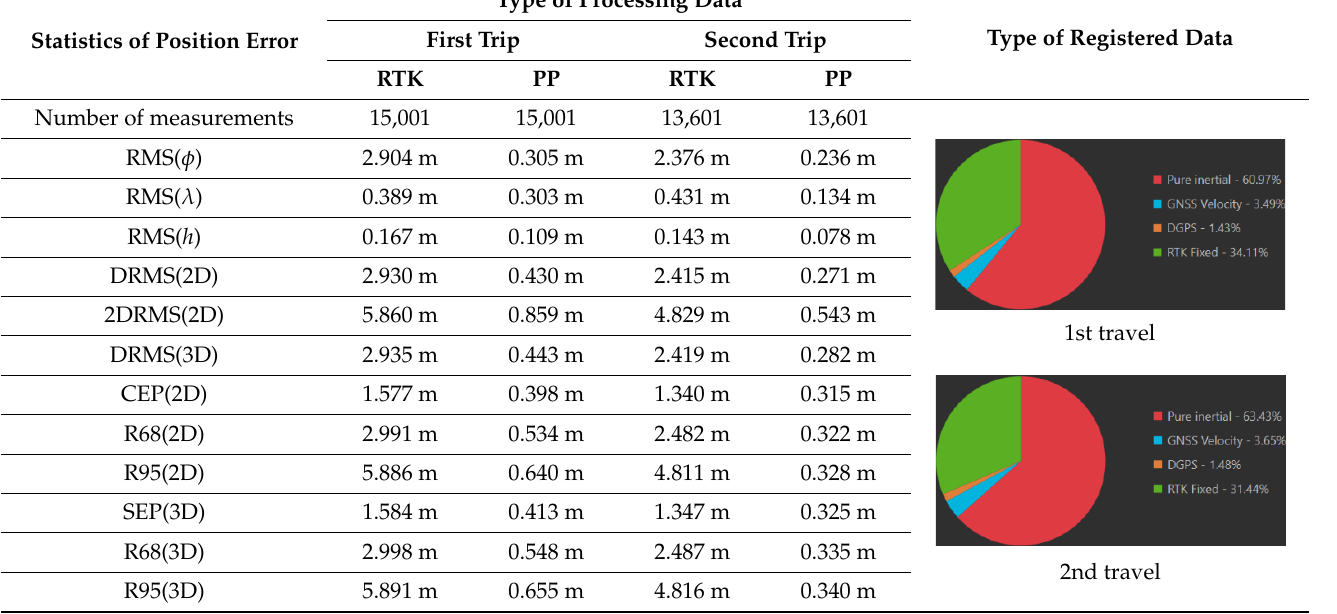
Figure 11. Variability in position errors recorded by the GNSS/INS system in the PP mode in section no. 2. Table 4. Predictable accuracy of the Ekinox2-U system during the GNSS/INS measurements in section no. 3.